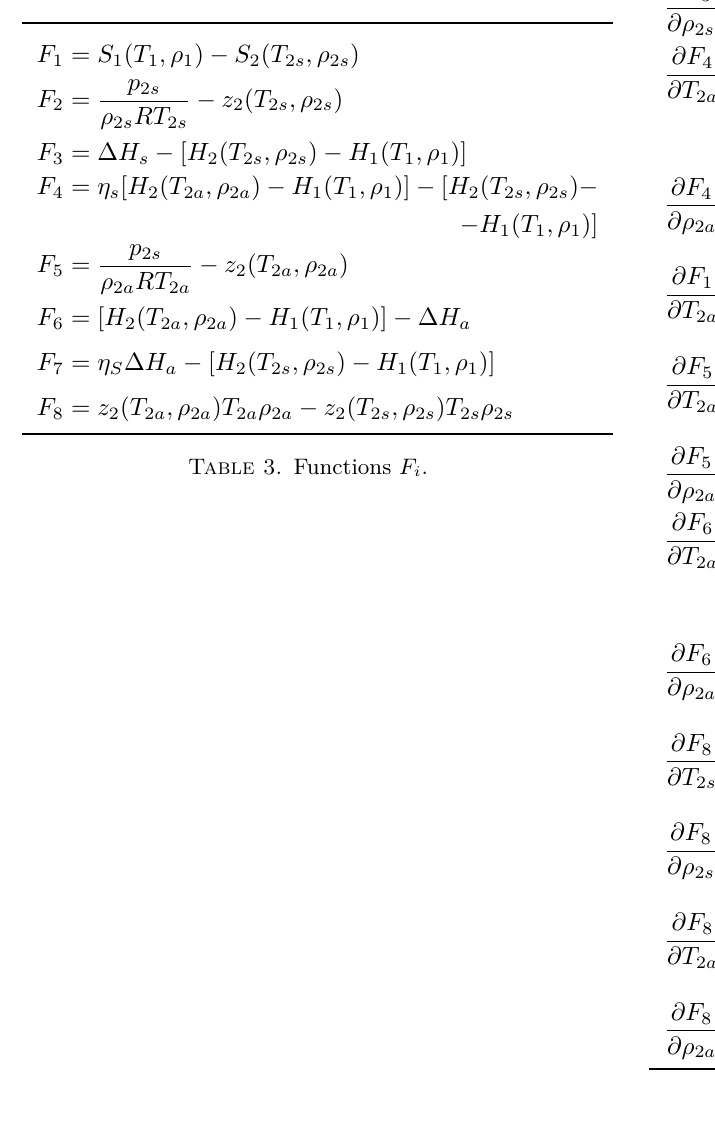
Table 4. Derivative of functions F